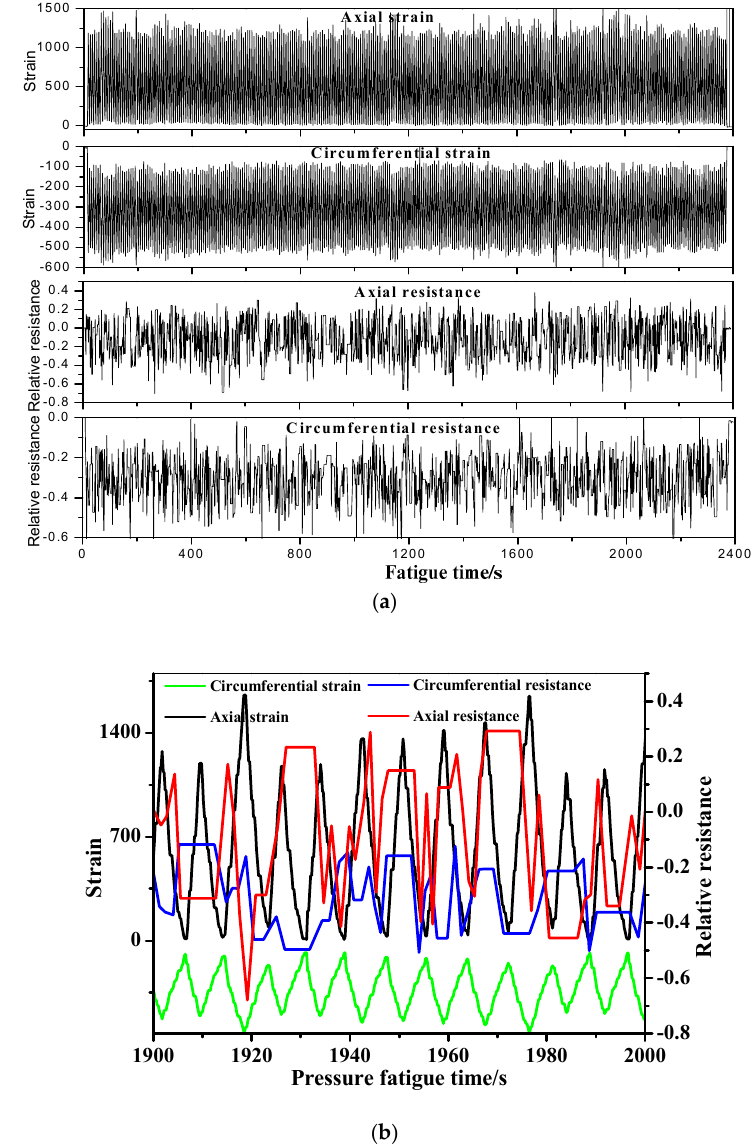
Figure 12. The monitoring results of the developed MWCNT sensor and the stain when the filament wound pressure vessel is in 2100- to 2400-cycles loading. The strain is measured by strain gauge-1 in Figure 4. ( a ) Resistance, the stain as the function of fatigue time. ( b ) The enlarged drawing